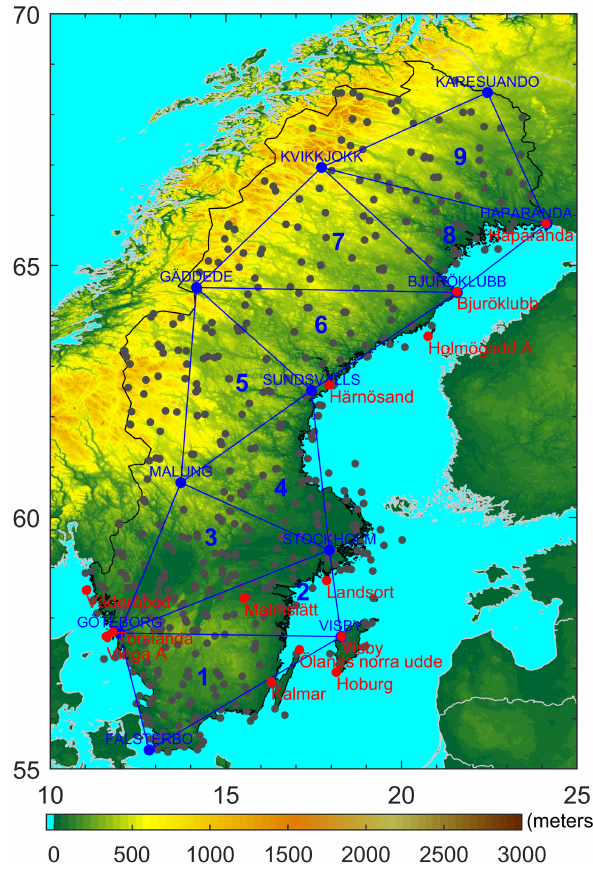
Figure 1. Map of the 13 stations (red points), with century-long rescued wind speed series and nine pressure triangles (blue lines) used to calculate the geowind data since 1925. Other weather stations in Sweden, installed to measure routine meteorological variables since 1956–1978s, are shown as grey points. Shading is the topography (in meters) from the global 30arcsec elevation dataset